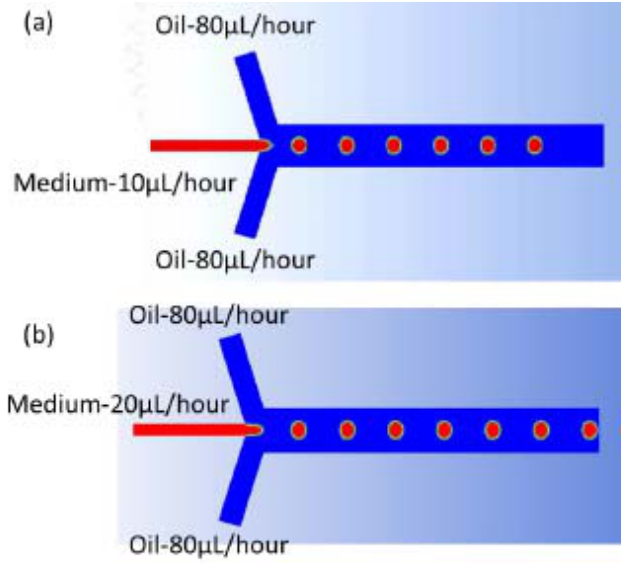
Figure 8. The schematic that was obtained from ANSYS simulation. ( a ) The oil flow rate is 80 µL/hour and the medium is 10 µL h − 1 ; ( b ) The oil flow rate is 80 µL/hour and medium is 20 µL h − 1 .